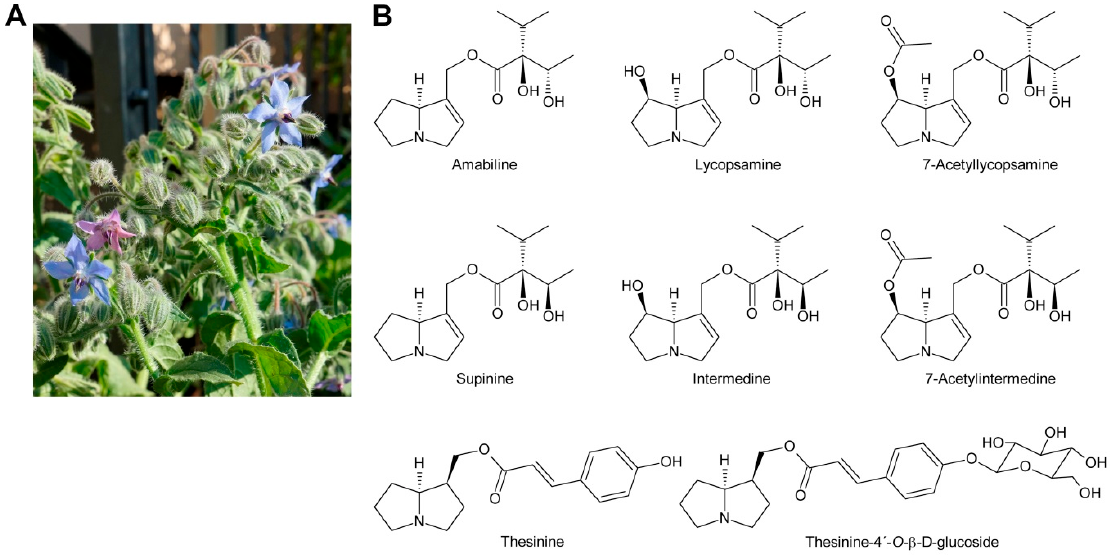
Figure 17. Pyrrolizidine alkaloids found in Borago officinalis (borage): ( A ) Flower of B. officinalis . Young flowers show a bright blue color while older flowers exhibit, because of a lower pH, a slightly reddish coloration. ( B ) Leaves of B. officinalis contain the supinidine-type PAs amabiline and supinine and the retronecine-type lycopsamine and intermedine as well as their 7-acetylated derivatives. Seeds contain mainly the (-)-isoretronecanol-type PA thesinine and its glucoside thesinine-4 ′ - O - β - D -glucoside.